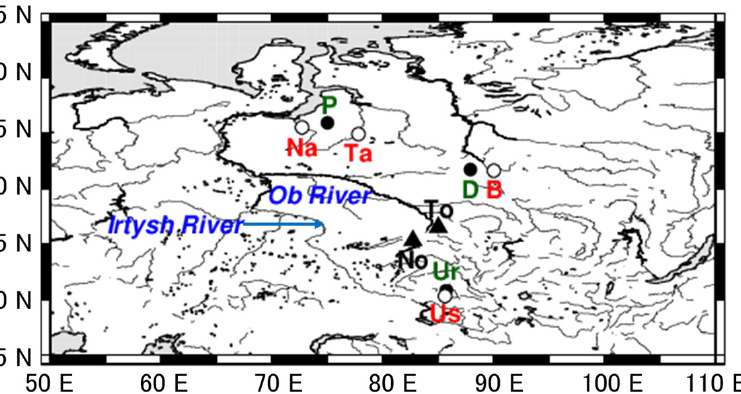
Figure 1. Study area. Tomsk and Novosibirsk are represented by black triangles whereas black circles are the experimental basins listed in Table 1. White circles are meteorological stations listed in Table 2. B: Bor, D: Dubches at Sandakches, Na: Nadym, No: Novosibirsk, P: Pravaya Khetta at Pan- gody, Ta: Tarko-Sale, To: Tomsk, Ur: Ursul at Onguday, Us: Ust-Koksa. Tomsk is located on the right bank of Tom River, a tributary of Ob River.